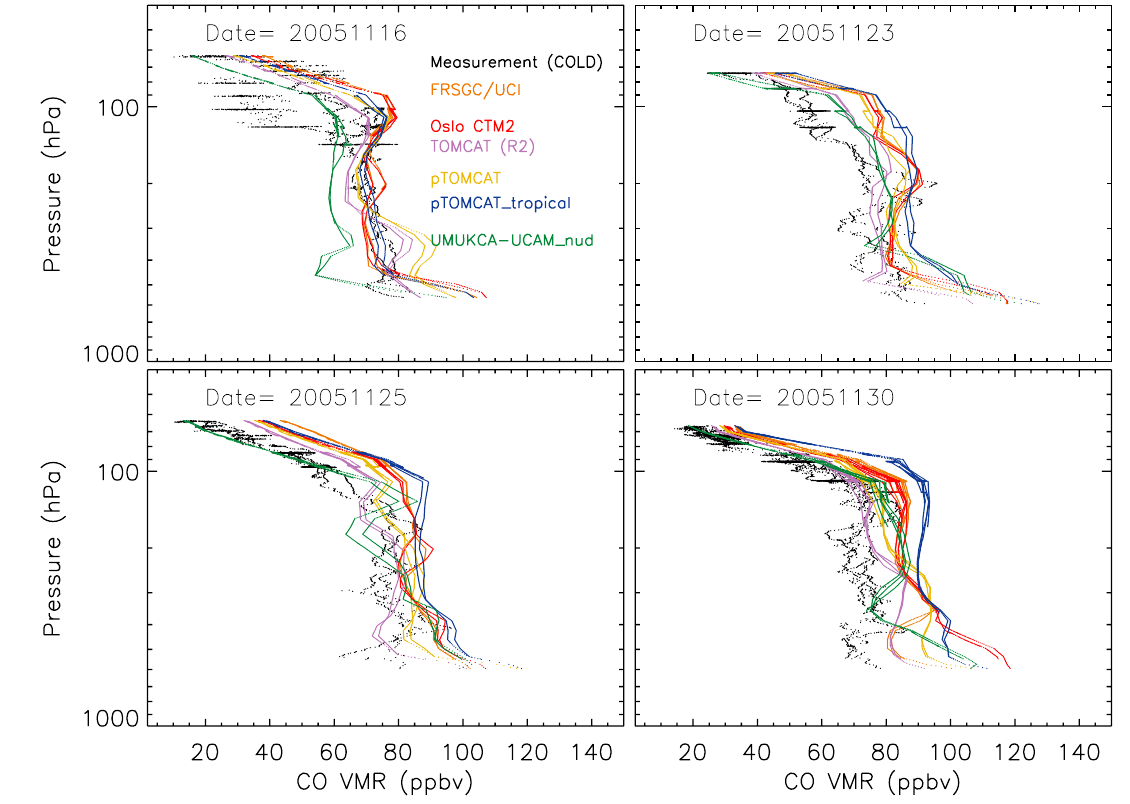
Fig. 8. A comparison between modelled and measured CO mixing ratios along the Geophysica flight track for 16, 23, 25 and 30 November 2005. The measurements were made during the SCOUT-O3 campaign in Darwin, Australia.